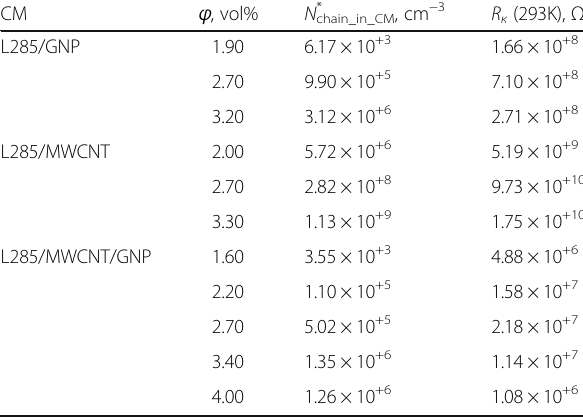
Table 3 Parameters of the polymer/nanocarbon CM with different concentration of the conductive filler CM ϕ , vol% N * chain_in_CM , cm − 3 R к (293K),